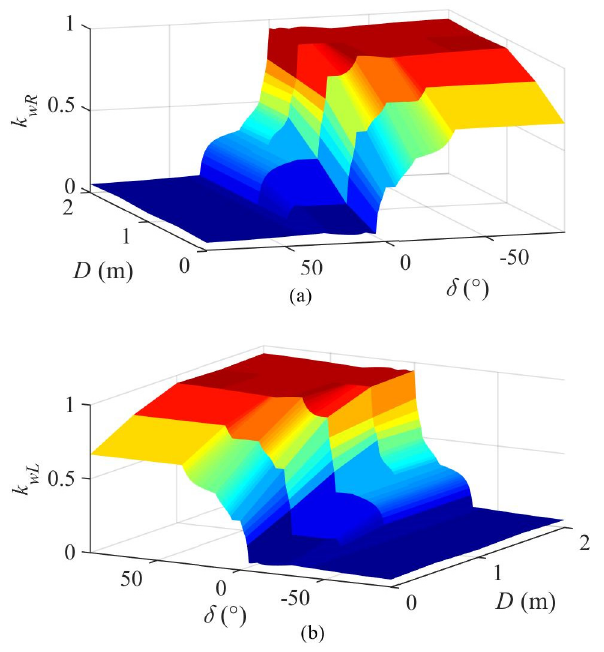
Figure 8. Surfaces for multiples of the maximum speed: ( a ) of the right engine; ( b ) of the left engine which are the approximation of the fuzzy control surfaces by a table with k D = 0.5 m and k δ = 1°.